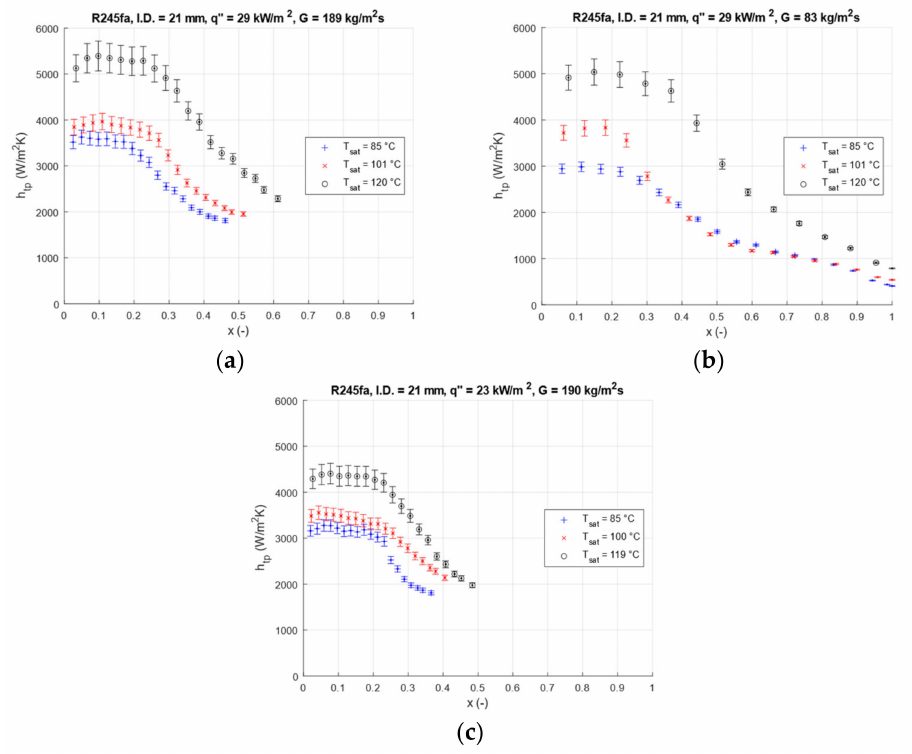
Figure 8. Local experimental two-phase heat transfer coefficients at changing saturation temperature, at . q case ( Re L = 20,045–31,007), ( b ) fixed low- G and high- ( a ) fixed high- G and high- . q case ( Re L = and ( c ) fixed high- G and low-